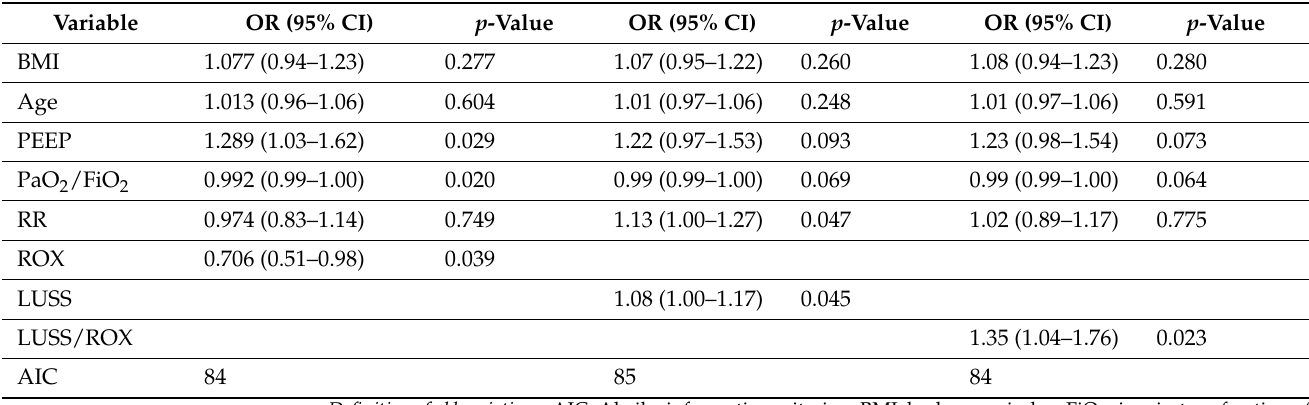
Table 2. Multivariable analysis of factors, including ROX index, independently associated with probability of negative outcome.